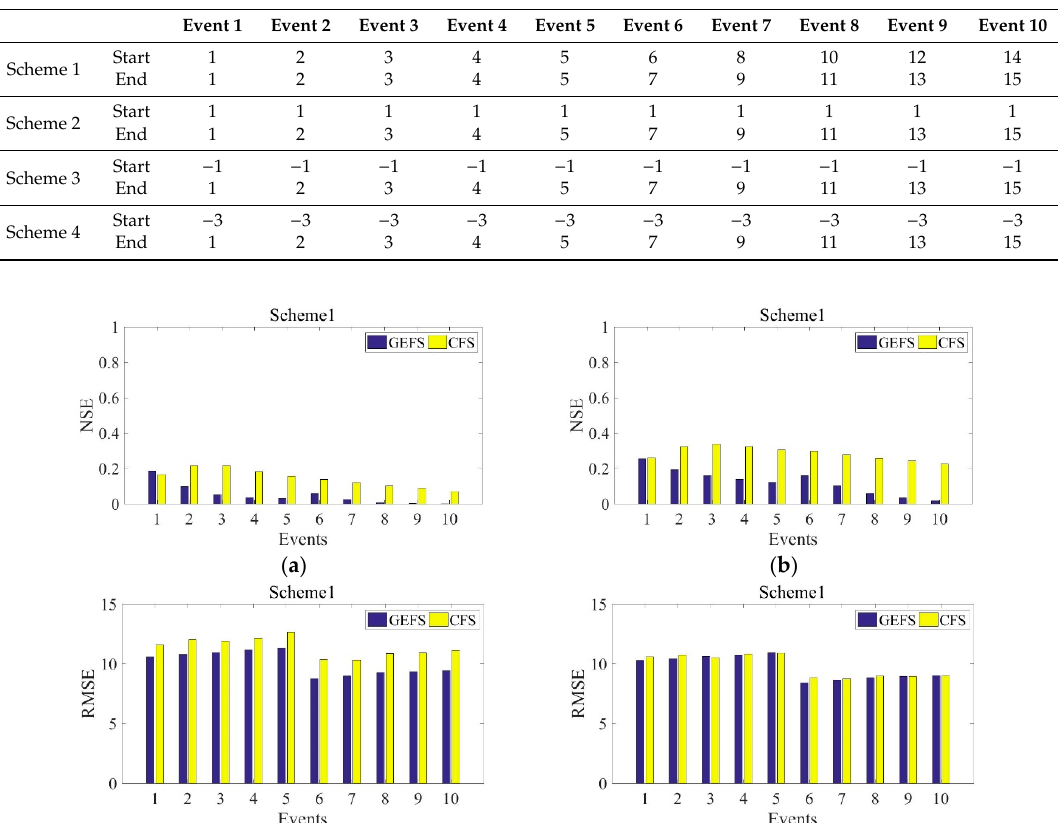
Table 2. Designed schemes of canonical events.